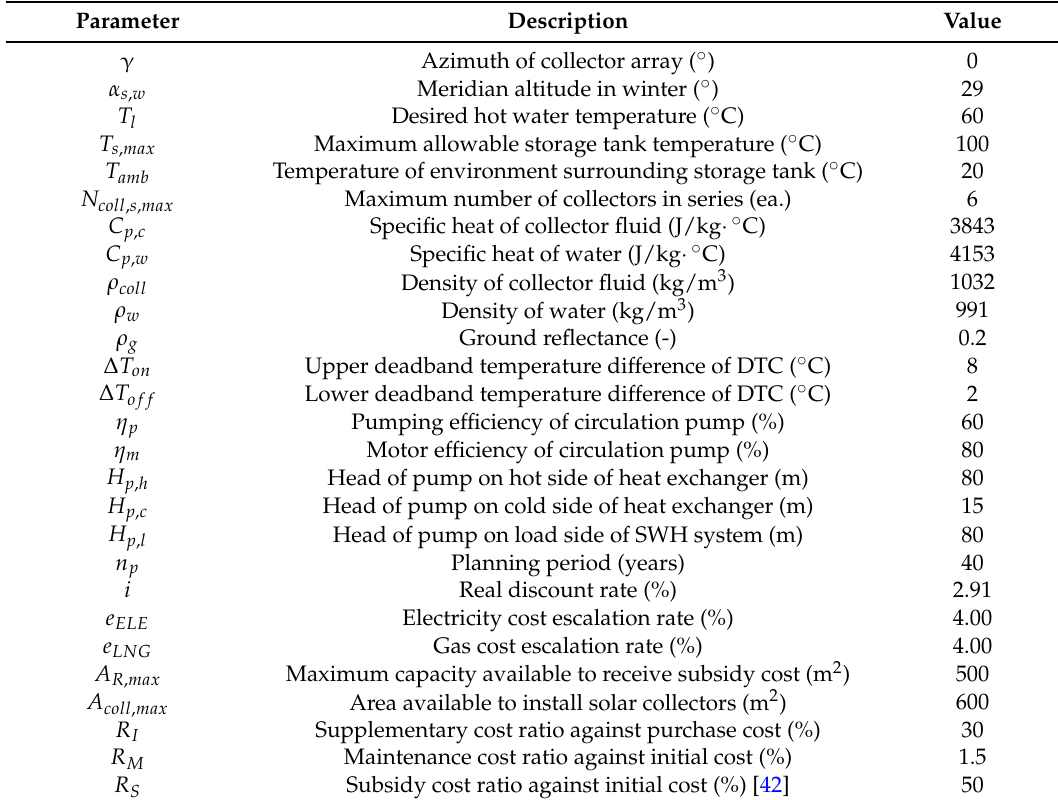
Table 1. Optimization parameters considered in case study.